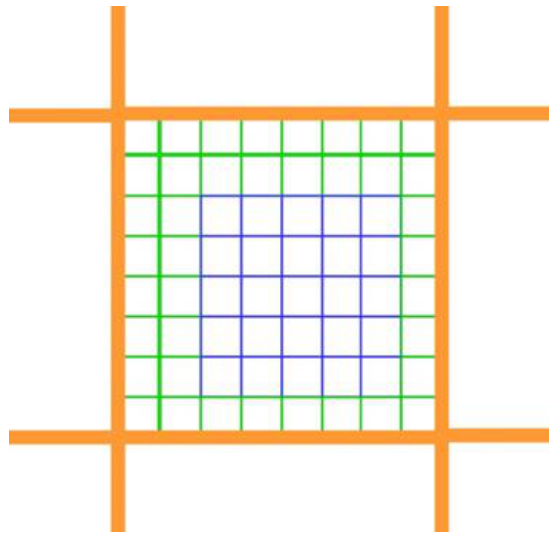
Figure 8. Example of projection after the border is added.